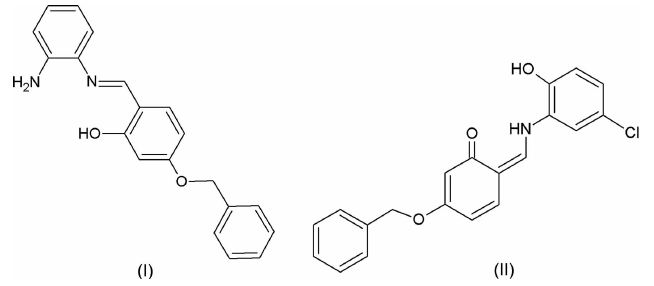
Table 2 Hydrogen-bond geometry (A˚ , (cid:2) ) for